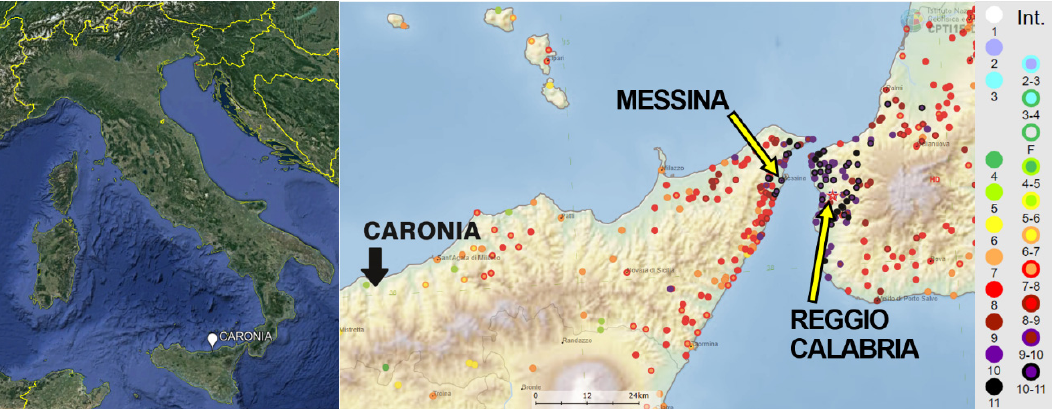
Figure 1. View of the study area with map of the involved locations during the 1908 earthquake.